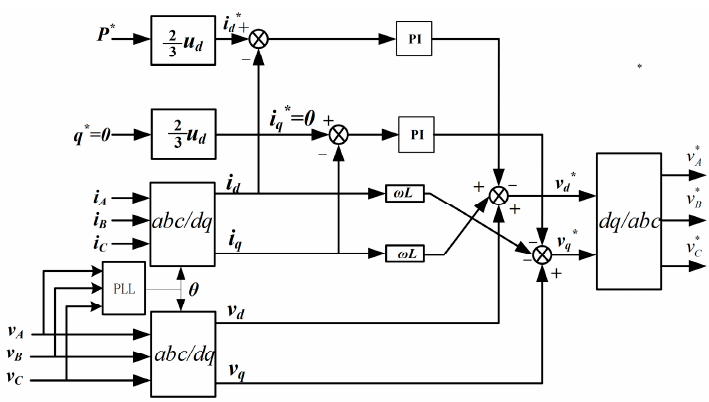
Figure 2. Power control block diagram for a flexible group battery energy storage system (FGBESS).